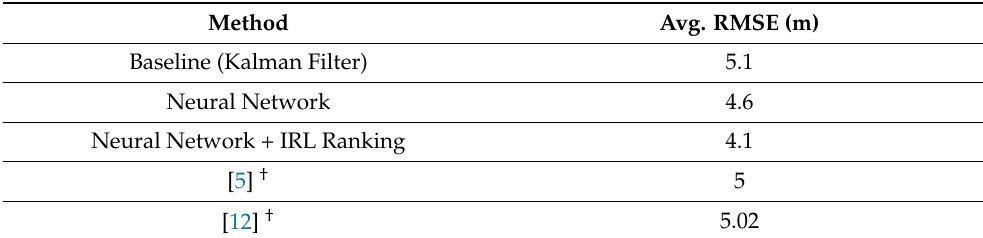
Table 4. Summary of Results.